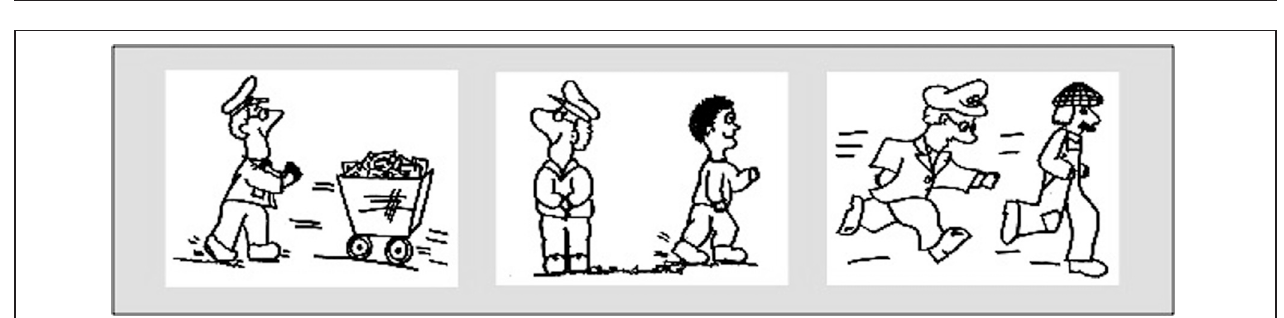
FIGURE 3 | Michotte’s (1963) entraining event (A) and launching with a gap (B).